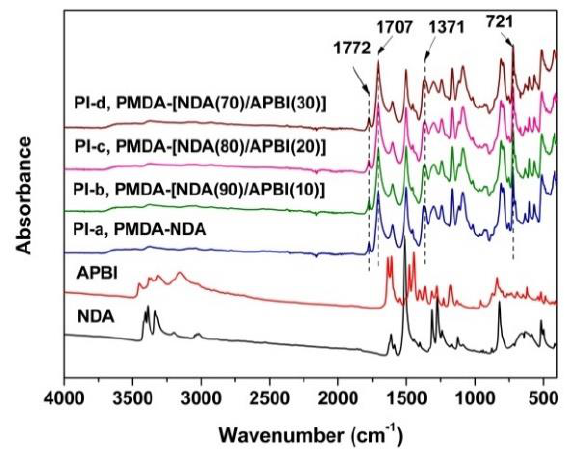
Figure 3. Attenuated total reflectance Fourier transform infrared (ATR-FTIR) spectra of PI films and the starting diamine monomers.